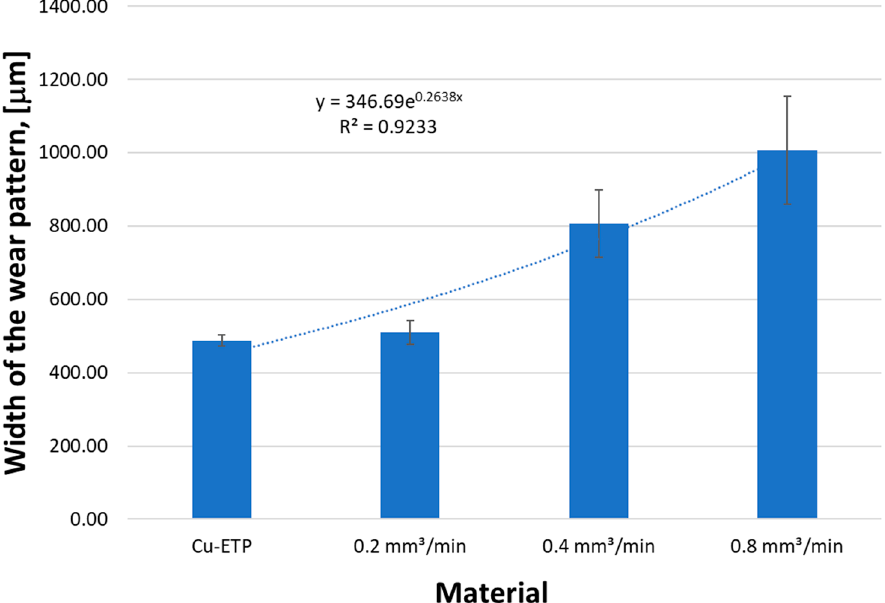
Figure 20. E ff ect of the CrAl powder feed rate during laser remelting on the width of the wear trace.